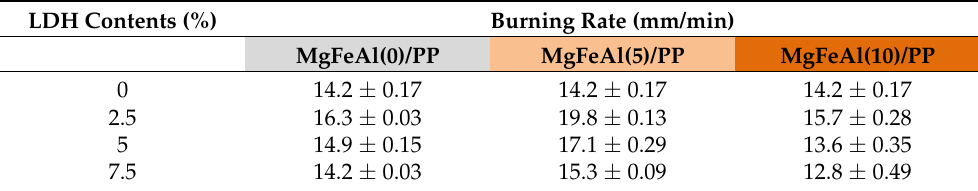
Table 4. Burning rate of different LDH/PP